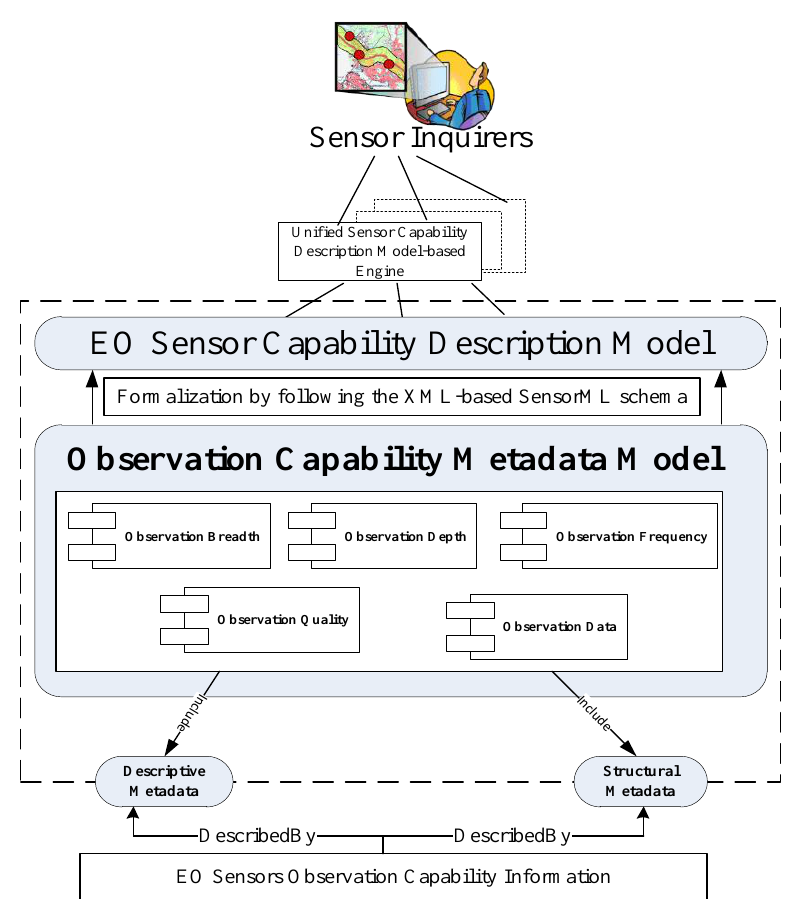
Figure 1. Architecture of the EO sensor discovery